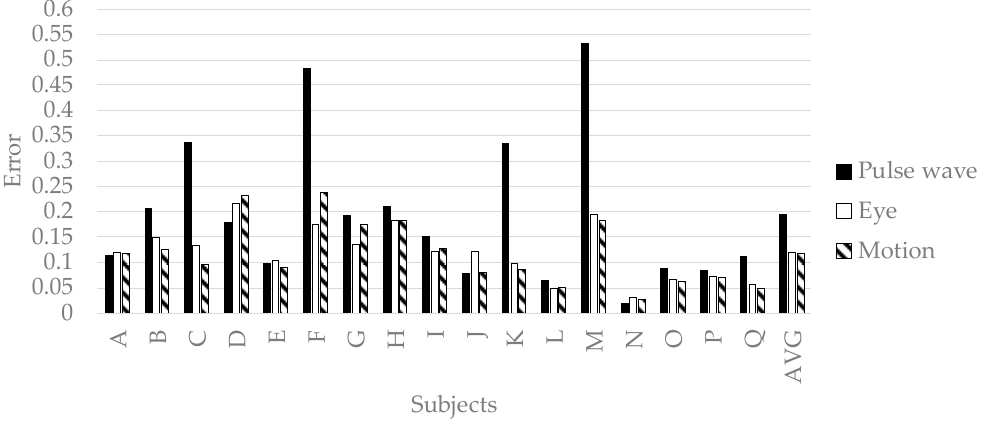
Figure 10. The accuracy of personalized model of pleasant emotion.